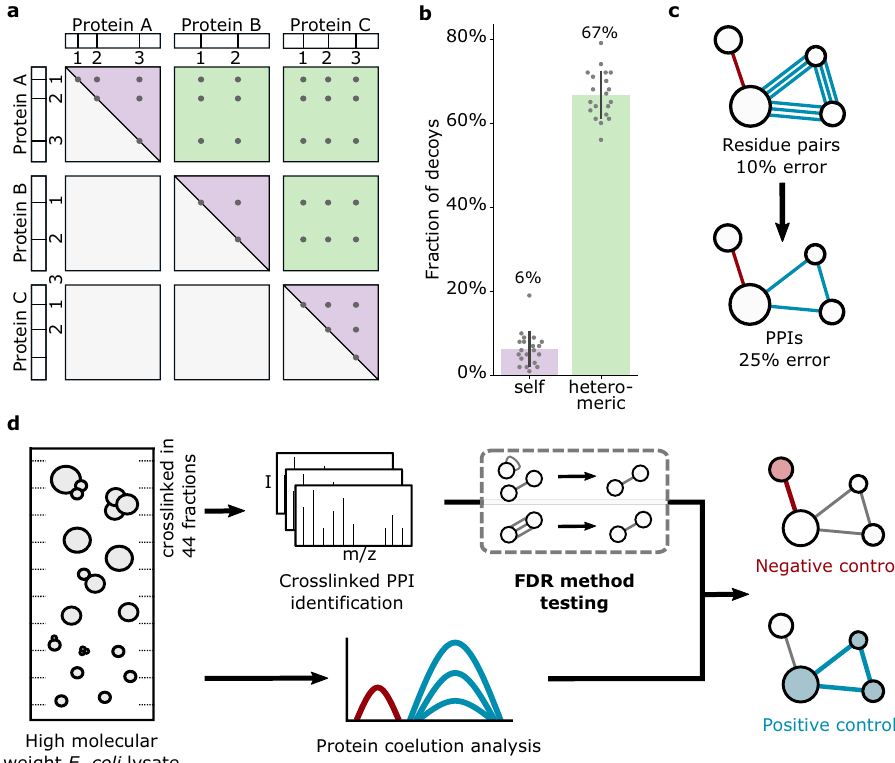
Fig. 1 Considerations for crosslinked PPI-FDR and experimental work fl ow. a For matches within the same protein sequence (with a non-directional crosslinker 17 ), a crosslink from A1 to A2 is indistinguishable from A2 to A1 (theoretically possible search space shown as purple triangles). In contrast, heteromeric matches are not symmetrical, and therefore occupy a larger random space (green squares). b Fraction of decoys in random picks of 100 self and 100 heteromeric CSMs from the search output before any FDR fi ltering (random picks, n = 20, i.e. ten per crosslinker dataset). Error bars show standard deviation from the mean. Source data are provided as a Source Data fi le. c Schematic showing error increase when merging crosslinked residue pairs to PPIs. Proteins are indicated as circles; blue and red lines represent true and false linkages, respectively. d Experimental work fl ow. E. coli lysate was separated and crosslinked in individual high molecular weight fractions, pooled again to simulate a complex mixture and analyzed by mass spectrometry. Quantitative proteomics of uncrosslinked fractions provided protein coelution